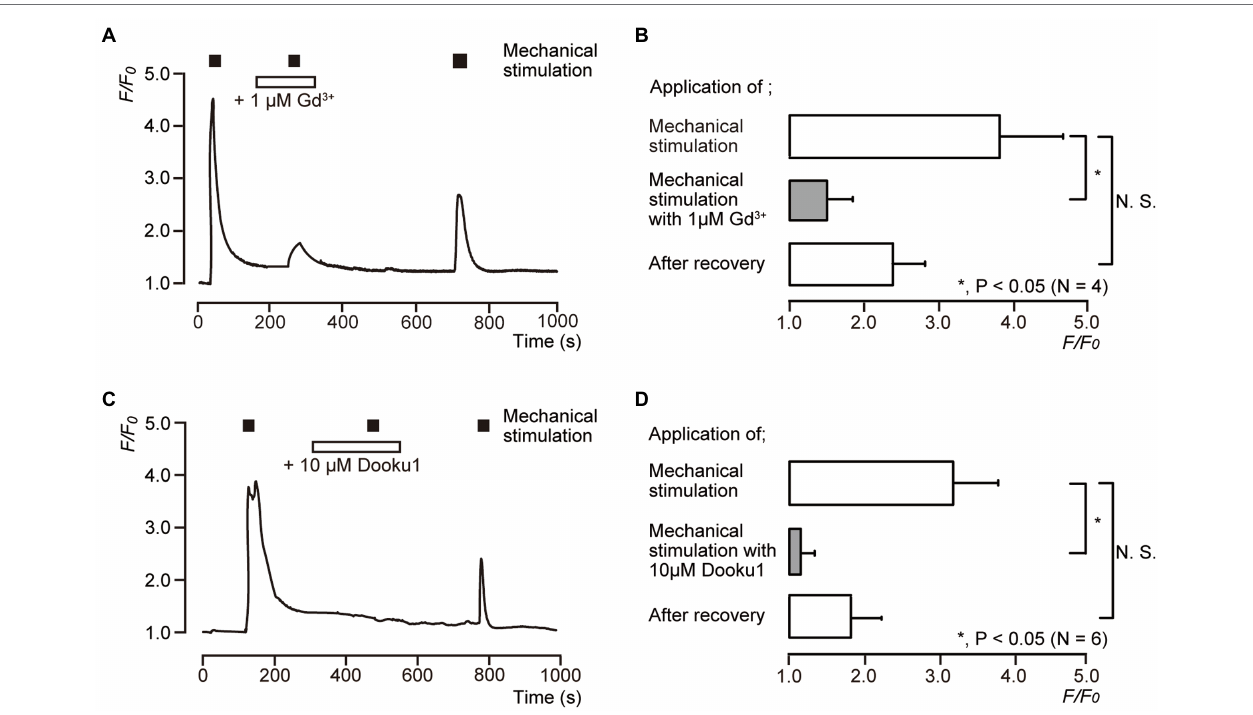
FIGURE 4 | Direct mechanical stimulation-evoked [Ca 2+ ] i increases mediated by a Piezo1 channel. (A,C) Representative traces of transient increases in [Ca 2+ ] i during mechanical stimulations induced by vertical micropipette displacement downward by 8.0 μ m (black boxes at the top in A,C ) in standard extracellular solution with (white boxes at the top) or without 1 μ M Gd 3+ (A) or 10 μ M Dooku1 (C) . (B,D) Bar graphs of the values of [Ca 2+ ] i increases induced by mechanical stimulation (to 8.0 μ m) without (open columns) or with (gray columns) pharmacological inhibitors, 1 μ M Gd 3+ (B) , or 10 μ M Dooku1 (D) . Each of the most lower open columns indicates the F / F 0 values after recovery. The resting value is shown as F / F 0 = 1.0. Each bar indicates the mean ± SD of four (B) and six (D) cells tested. Asterisks denote statistically significant differences between columns (shown by solid lines): * p < 0.05; N.S., not